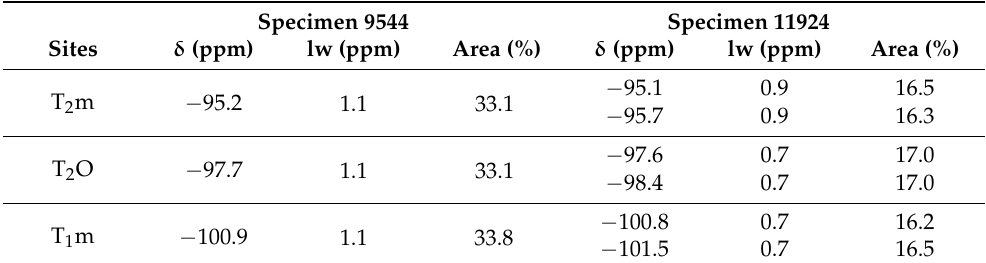
Table 11. The NMR parameters of the simulation of the 29 Si spectra in specimens 9544 and 11924, “X-ray low microcline” (LM) variant, at 9.4